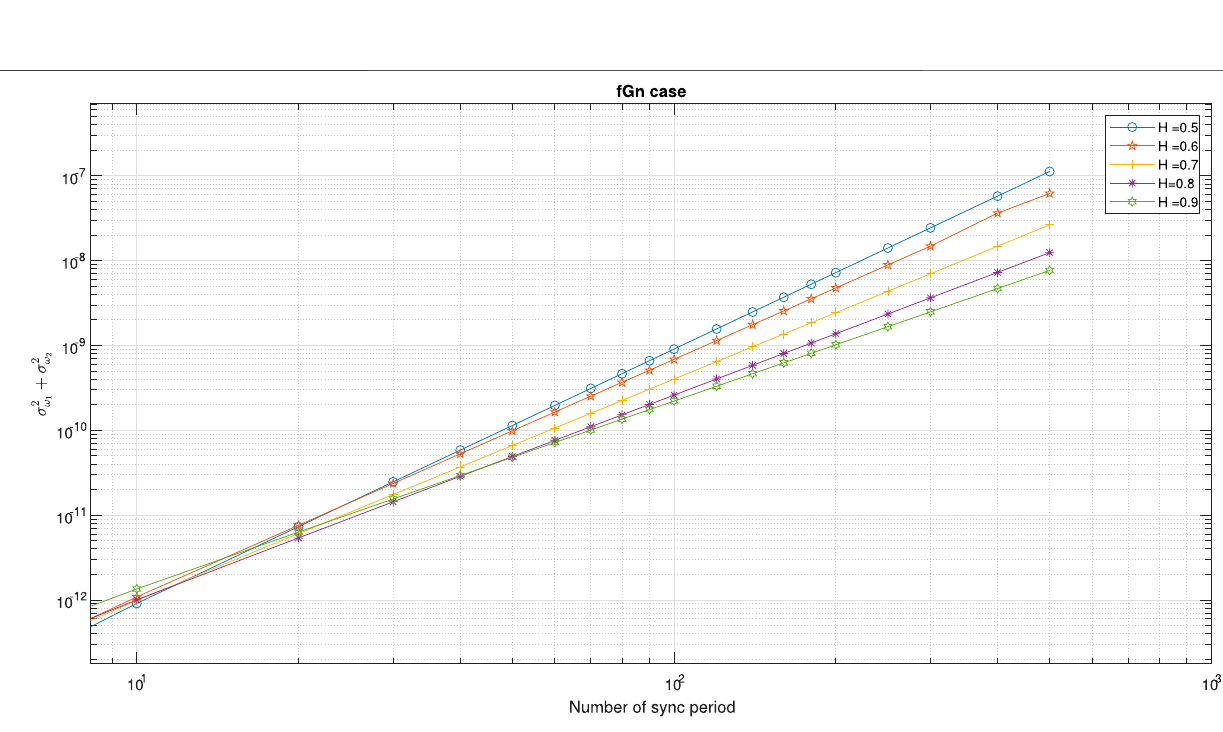
) and E [ e 2 ] (cid:1) 10 – 12 . sec